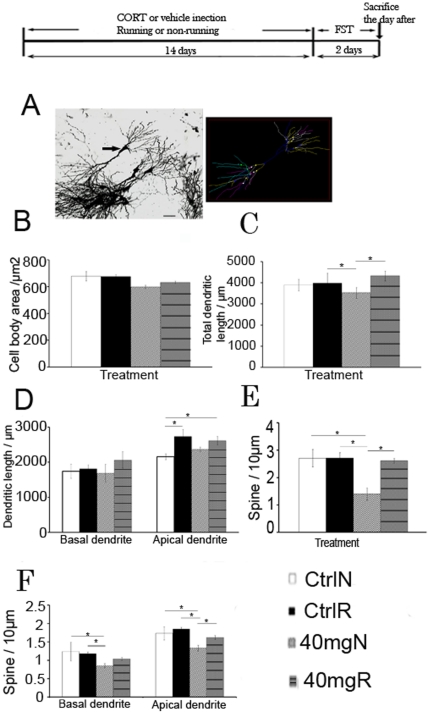
Dendritic remodeling of hippocampal CA3 pyramidal neurons.(A) Left: A representative image of a selected neuron for analysis; Right: A neuronal morphology by using Neurolucida software (B) The soma size was not affacted by running and CORT treatment. (C) CORT treatment significantly decreased total dendritic length while running reversed the decrease. (D) The basal dendritic length was not affected by running and CORT treatmnet. The apical dendritic length was significantly increased by running in vehicle or CORT treated rats. (E) Running did not increase spine density in vehicle-treated rats, but restored the decrease in 40 mg/kg CORT-treated rats. (F) Treatment with 40 mg/kg CORT significantly decreased spine density in basal dendrites and apical dendrites. Running restored the decrease in spine density in 40 mg/kg CORT-treated rats. *P<0.05; **P<0.005. N = 3 for control non-runnes, N = 5-8 for the rest groups. Ctrl: control; 40 mg: 40 mg/kg CORT; N: non-runner; R:runner. Scale bar = 100 µm. FST: forced swim test.